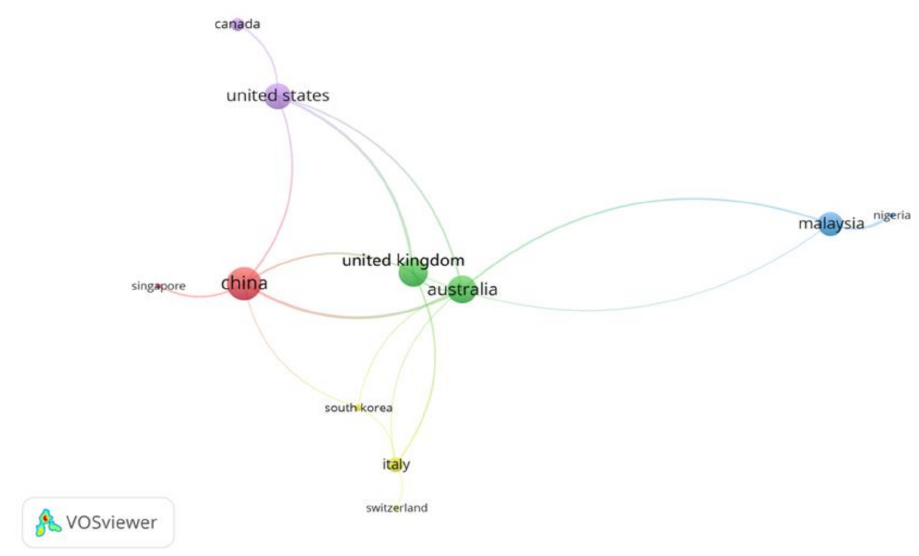
Figure 4. Countries that focus on research in the field of C4.0 and SD.